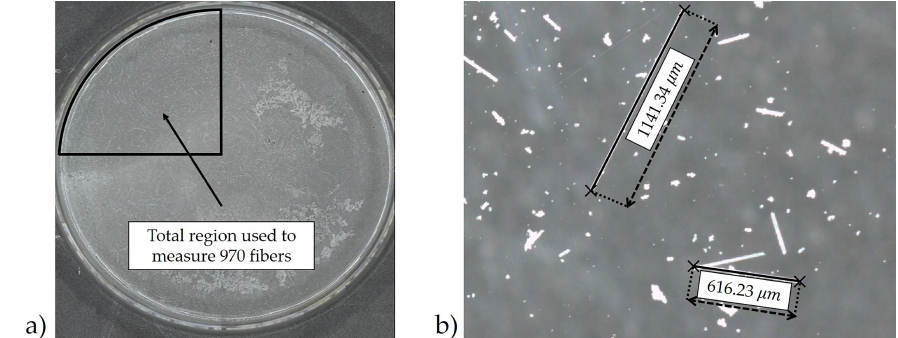
Figure 5. Steps for glass fiber measurements to determine the aspect ratio of the fibers ( a ) stitched image showing fibers collected in a petri dish ( b ) example fiber length measurements.